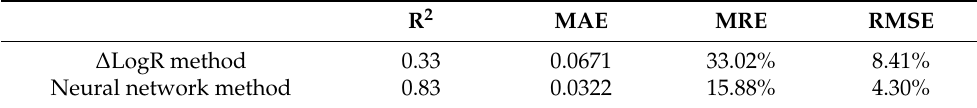
Table 3. Summary table of evaluation parameters.